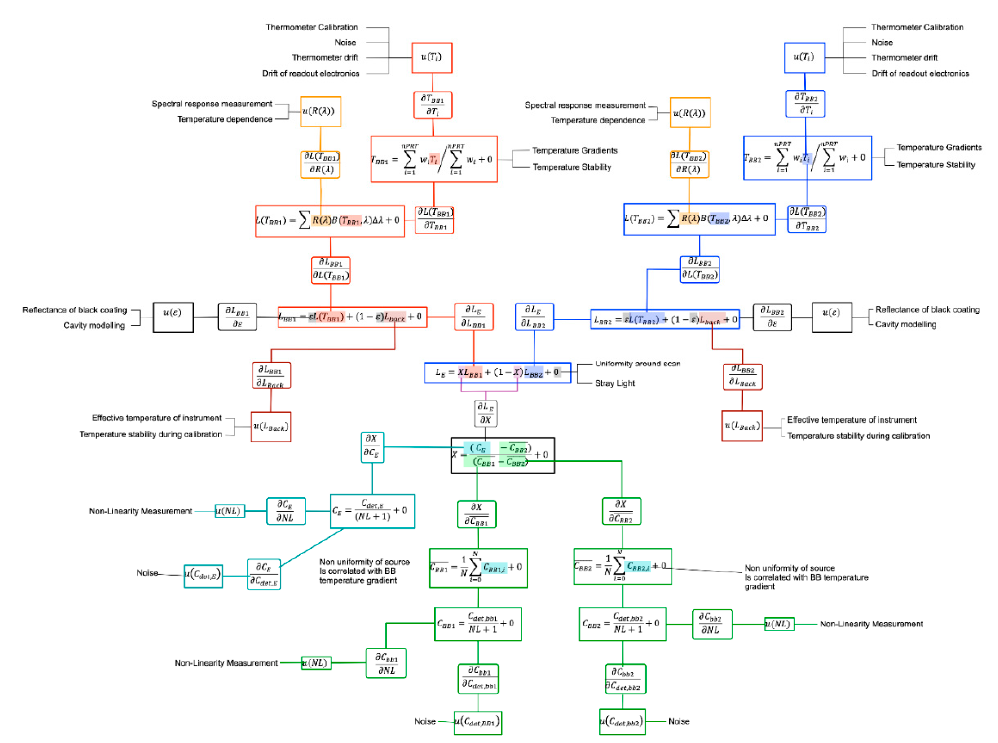
Figure 3. SLSTR TIR Calibration uncertainty tree diagram. A full size, easier to read version of this diagram is available in Appendix A.